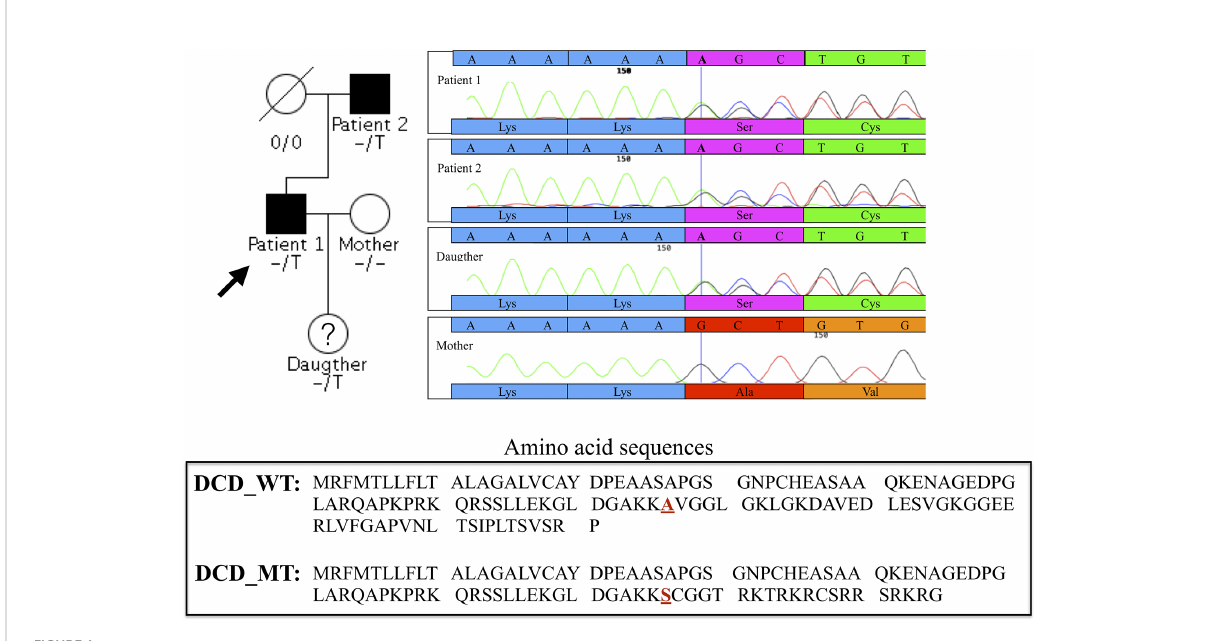
FIGURE 1 Family pedigree of the proband and chromatograms of the heterozygous single-nucleotide variation in exon 4 of DCD gene identi fi ed in the proband (Patient 1), Patient 2 and in the daughter, absent in the clinically healthy mother. The vertical bar in the electropherogram shows the site of rs538180888 insertion in exon 4, present in the two patients and the daughter but not in the